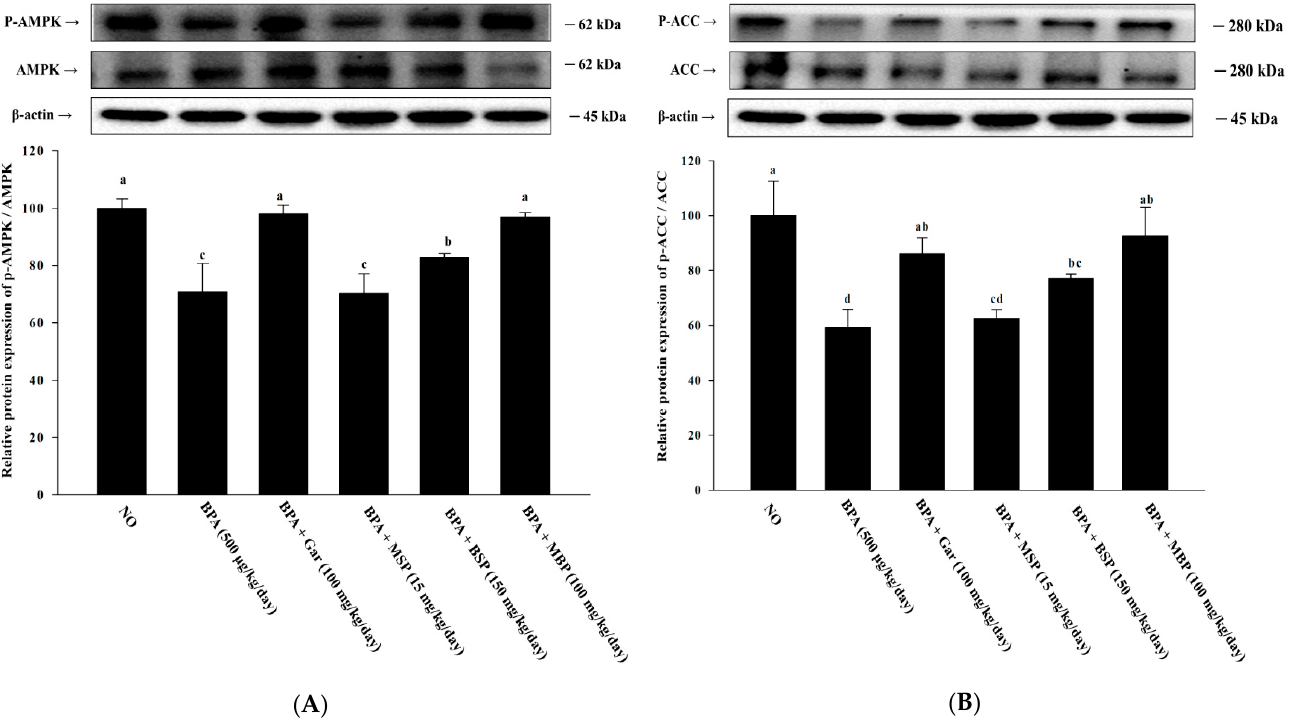
Figure 6. Effects of MBP, BSP, and MSP on the activation of AMPK pathway proteins (p- AMPK/AMPK ( A ), p-ACC/ACC ( B )) in epididymal adipose tissue. Each value is expressed as mean ± SD of three independent experiments. Different lower letters on the bars indicate statistical differences at p < 0.05.